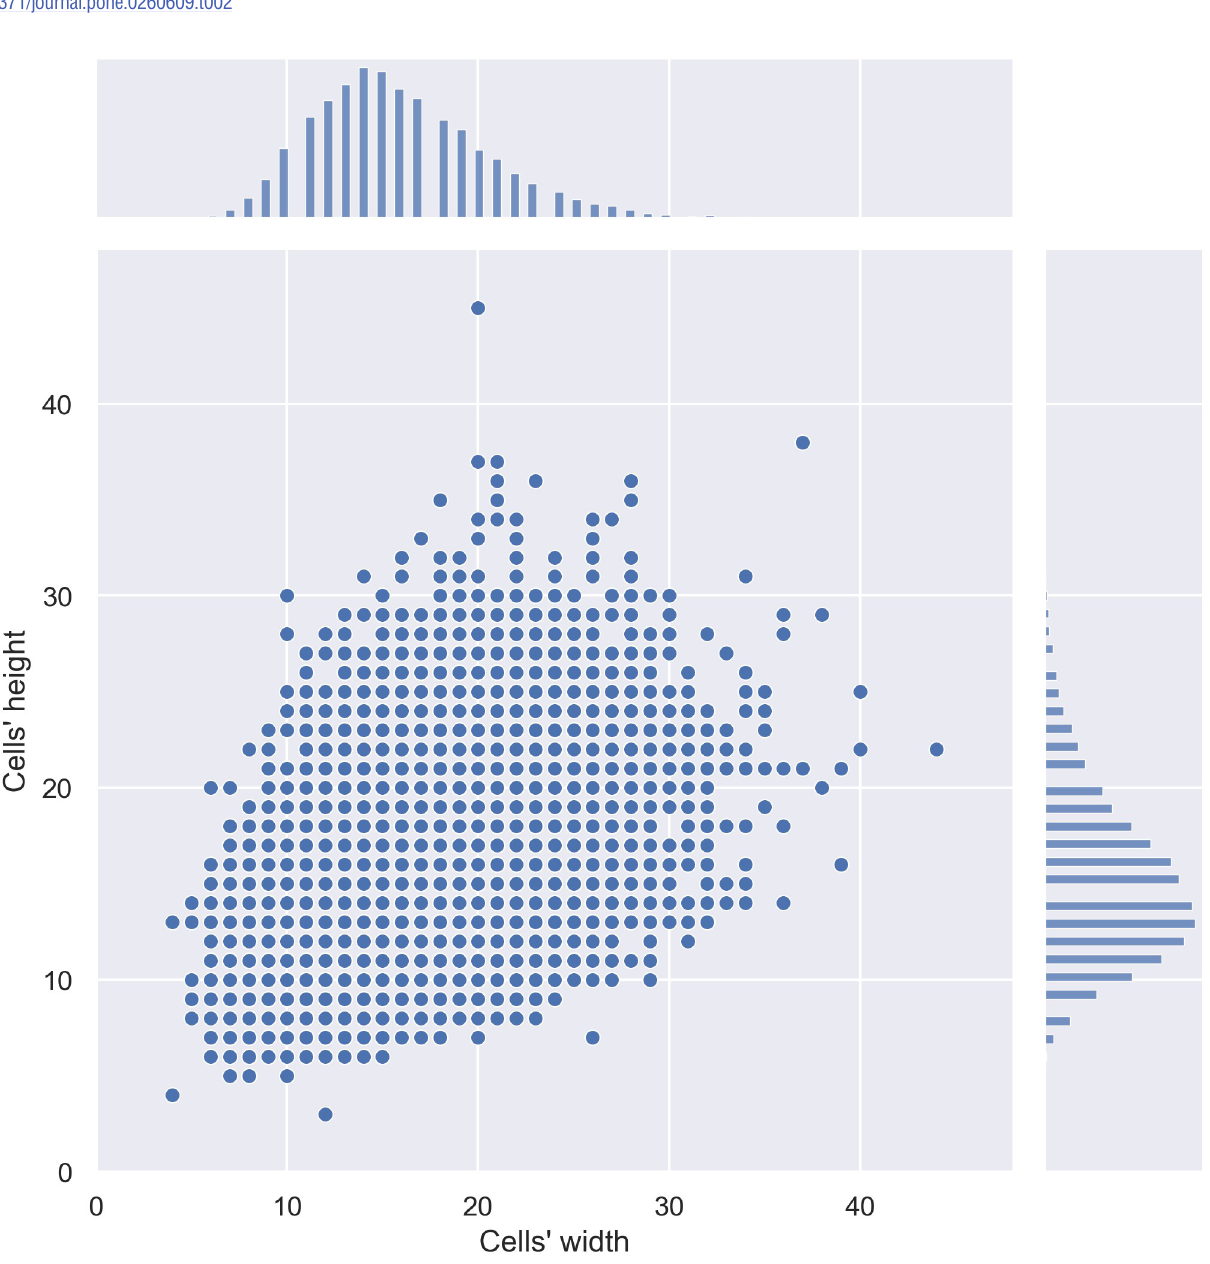
Fig 2. Joint and marginal distribution plot representing the density and distribution of the cells according to their width and height. Although it is normally distributed, we can verify the significant variance of cell morphology available in the data set.